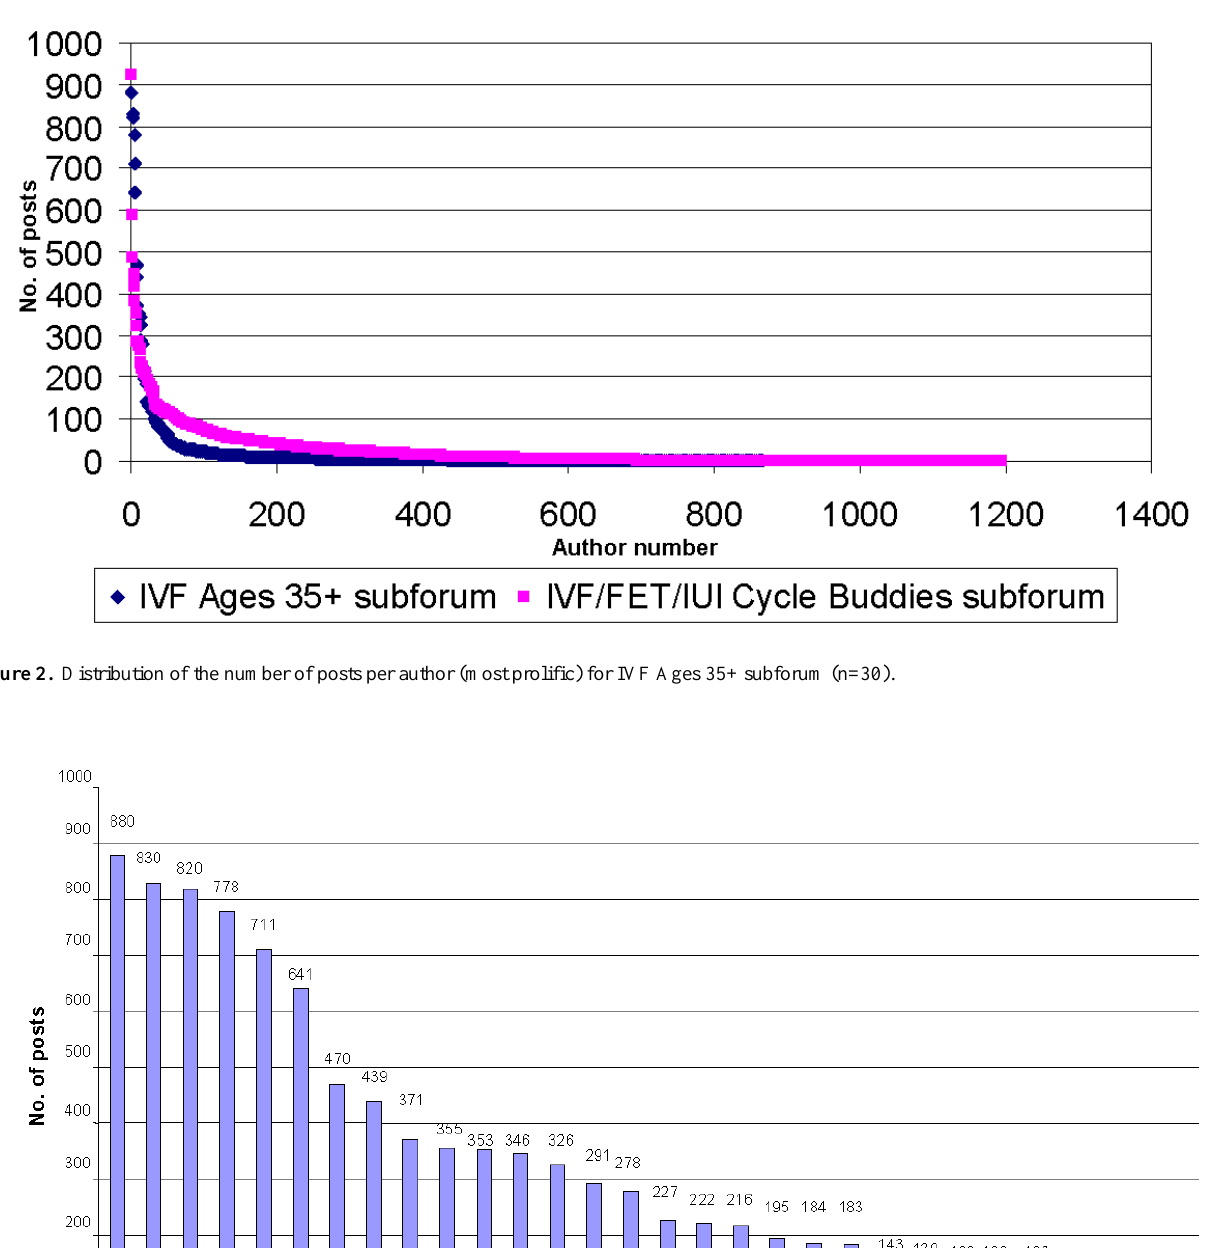
Figure 1. Number of posts per author distribution for the selected subforums, IVF Ages 35+ (n=865) and IVF/FET/IUI Cycle Buddies (n=1195).